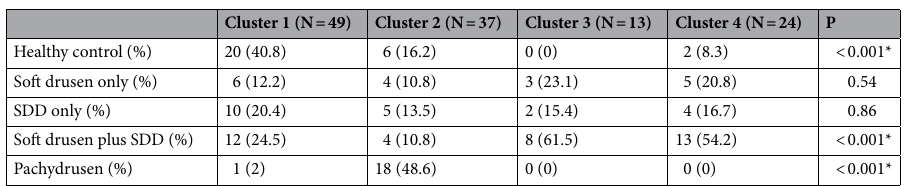
Table 2. Distribution of each drusen type in 4 clusters. SDD subretinal drusenoid deposit. *Significant difference among the 4 groups using the chi-square